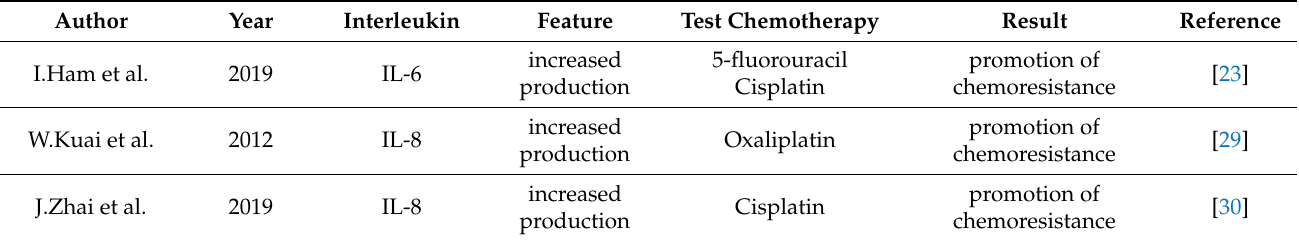
Table 1. Mechanisms of chemoresistance interleukins in treatment of GC.